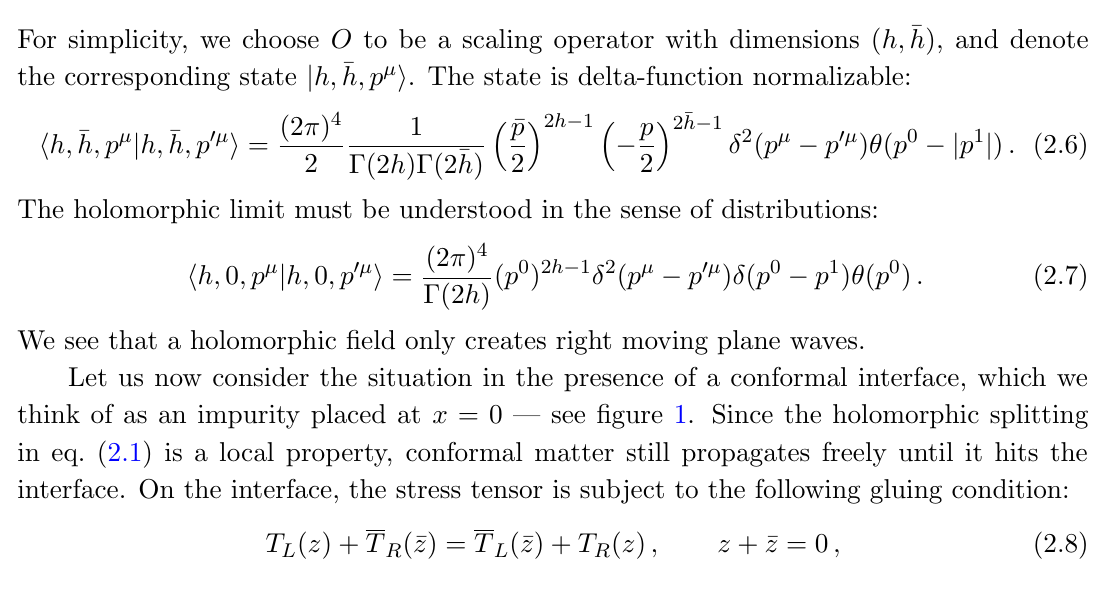
Figure 3 . The timelike momentum p (cid:22) uniquely decomposes in the lightlike momenta of the right and left movers. The time components of the latter coincide with the energy carried to in(cid:12)nity towards the right and towards the